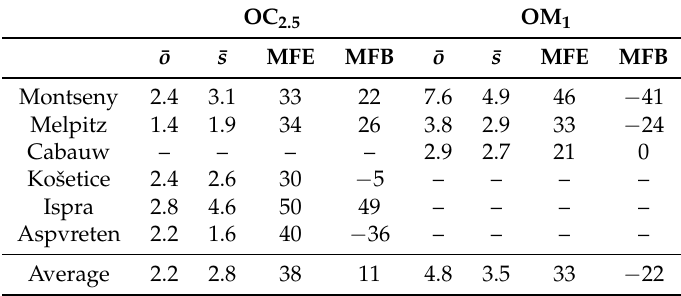
Table A3. Statistics (measured ¯ o and simulated ¯ s mean concentrations ( µ g m − 3 ), mean fractional error MFE (%) and mean fractional bias MFB (%)) of comparisons to measurements for daily concentrations of OC 2.5 (OC 10 at Aspvreten) and OM 1 when